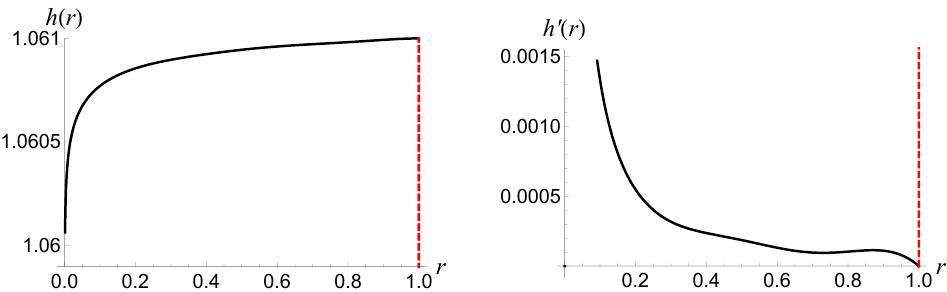
Figure 7 . The metric function h describing anisotropy in the black hole interior and its derivative h 0 . Note that h monotonically decreases towards as we flow towards the singularity. Furthermore, h 0 appears to rise in an unbounded manner, corresponding to an increasing gradient of h